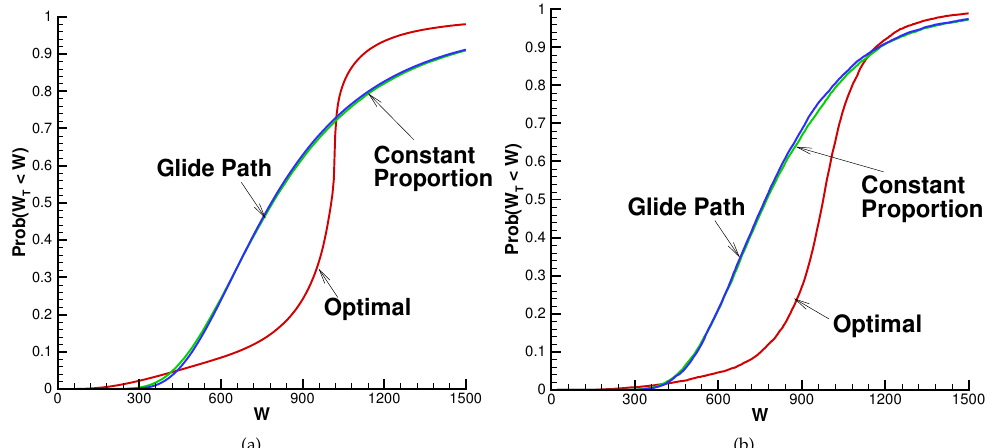
Figure 8. Cumulative distribution of real terminal wealth when the equal-weighted equity index is used. Wealth units: thousands of dollars. Input data provided in Tables 1 and 2, except as noted. Synthetic market results computed using Monte Carlo simulations with 160,000 sample paths. Historical market results based on 10,000 bootstrap resampled paths using data from 1926:1 to 2015:12 with expected blocksize ˆ b = 2 years; surplus cash flow included for the QS optimal strategy. ( a ) synthetic market; ( b ) historical market. Table 10. QS optimal results with varying salary replacement ratios R . Units for W d : thousands of dollars. Remaining wealth values are normalized by W d for each case. Input data provided in Tables 1 and 2, except as noted. Synthetic market results computed using Monte Carlo simulations with 160,000 sample paths. Historical market results based on 10,000 bootstrap resampled paths using data from 1926:1 to